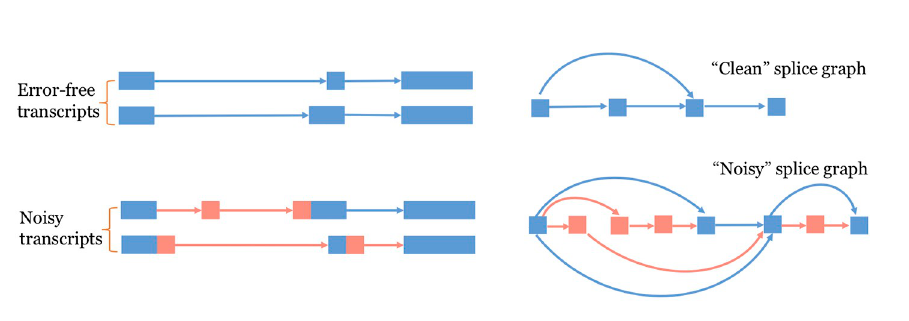
Fig 5. Noisy alignments make the splice graph vastly more complicated. The clean splice graph on the upper right is based on the two error-free transcripts, while the noisy splice graph is based on all four of the transcripts shown on the left. Regions shown in orange are errors due to